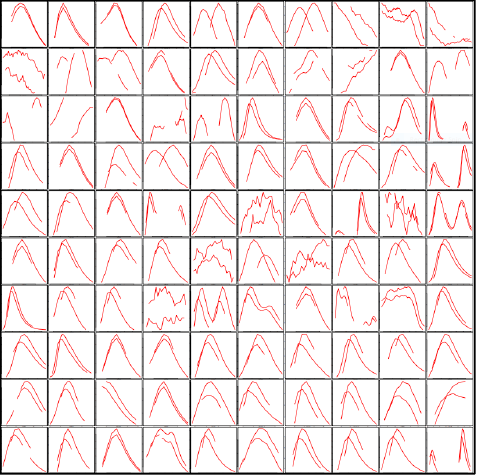
Figure 2. Example of graphical output for input-parameter evaluation.